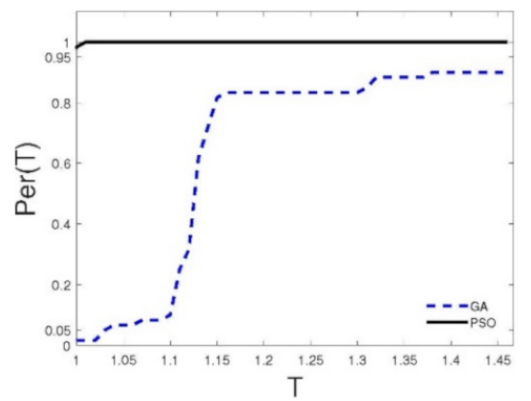
Figure 6. Dolan–Mor é diagram related to comparing PSO and GAs in improving of regularity of